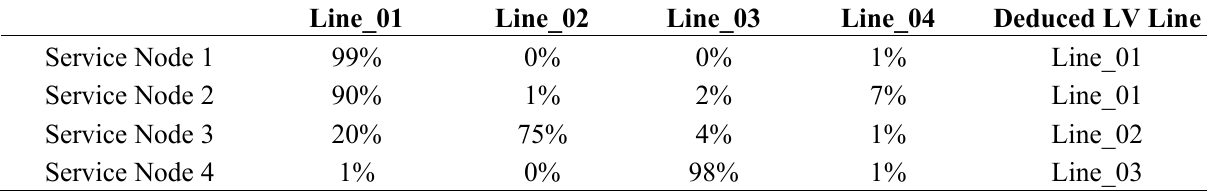
Table 4. Line detection information kept by the base node (BN).